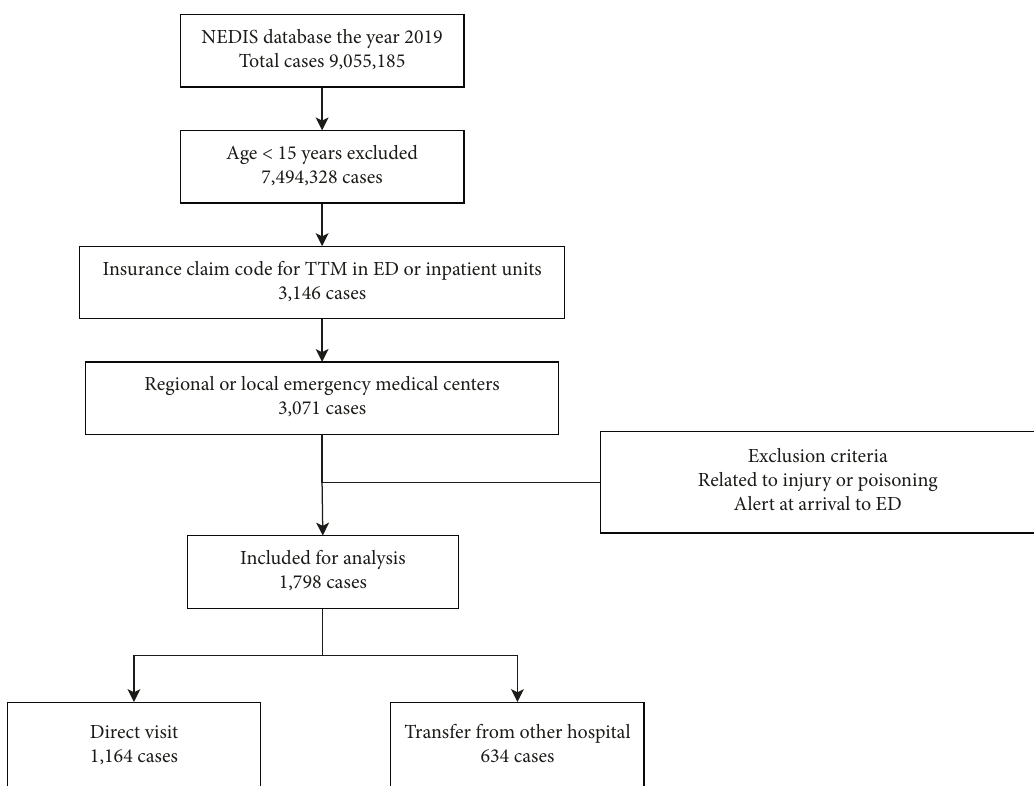
Figure 2: Flow diagram illustrating included and excluded cases who received therapeutic hypothermia. NEDIS: national emergency department information system; TTM: targeted temperature management; ED: emergency